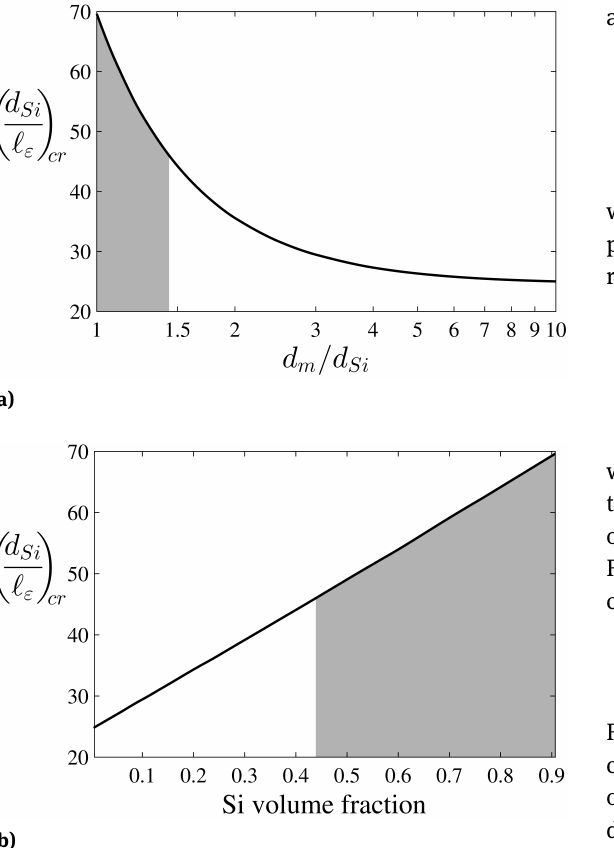
Figure 7: Critical ratio ( d Si / (cid:96) ε ) cr between the diameter of the silicon nanowire and the elastic internal length for the suppression of the theoretical fracture of Si vs. (a) the ratio of the unit cell diameter over active site diameter, and (b) the volume fraction of silicon in the nanocomposite for the densest unit cell packing possible. The grey regions indicate suppression of fracture for both the active site and the glass matrix.